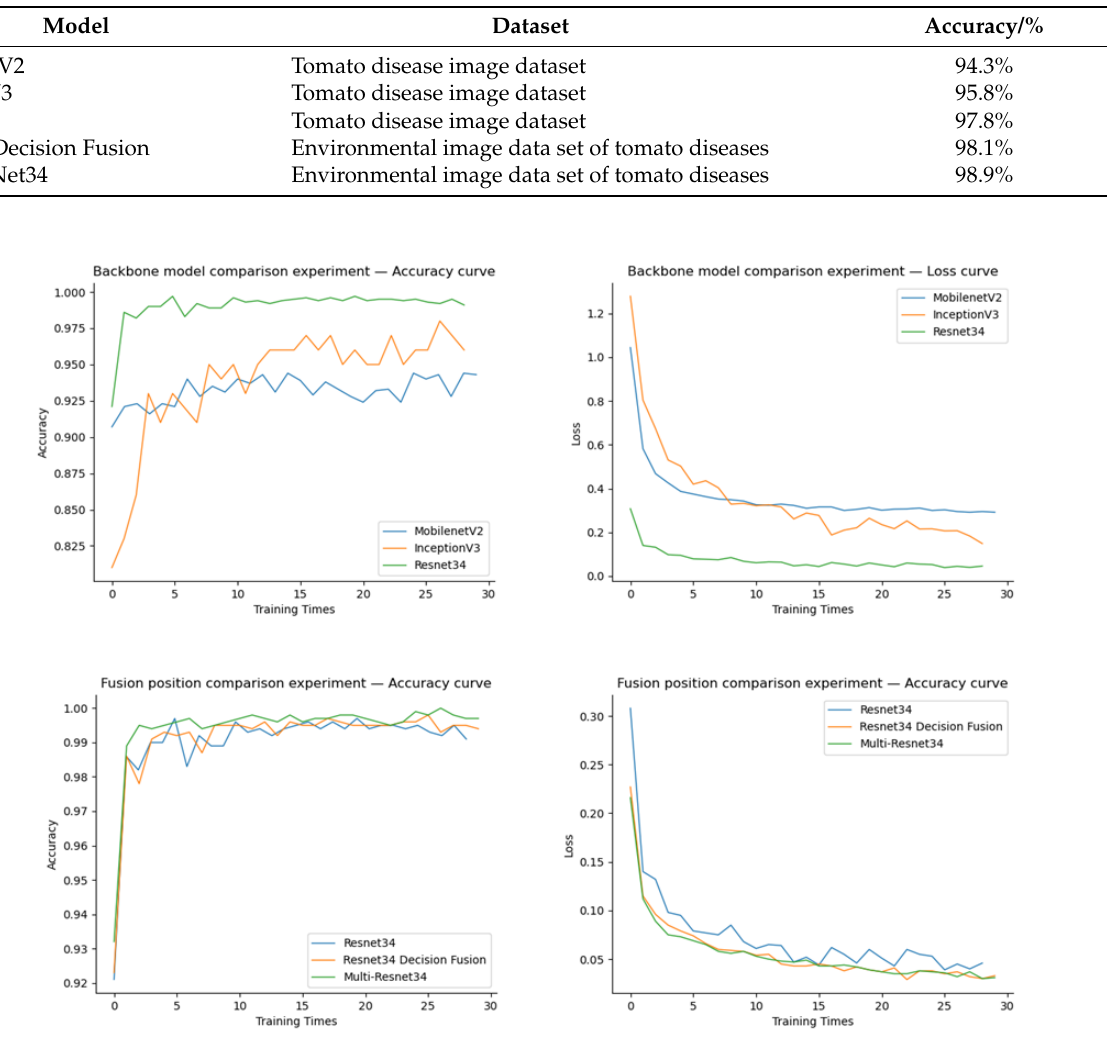
Table 3. Comparison of the recognition accuracy of different models.